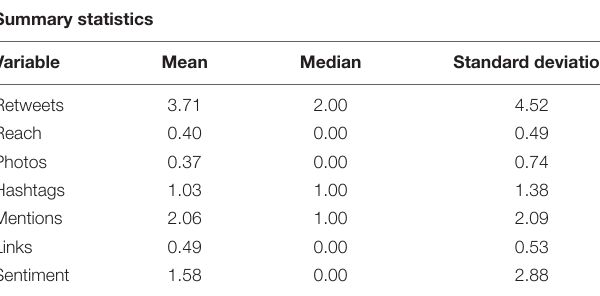
TABLE 5 | Summary statistics of variables used in the regression